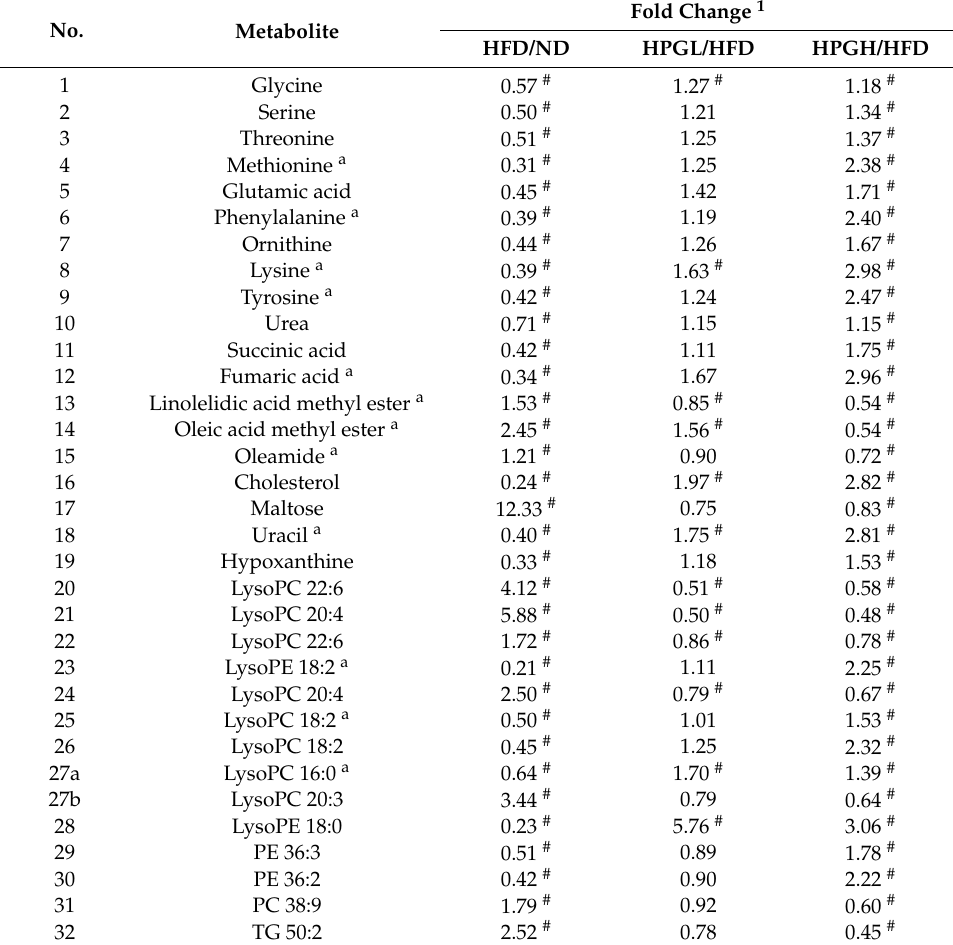
Table 4. List of potential hepatic biomarkers in mice fed a High-Fat Diet (HFD) including 5% Platycodon grandiflorum using various MS